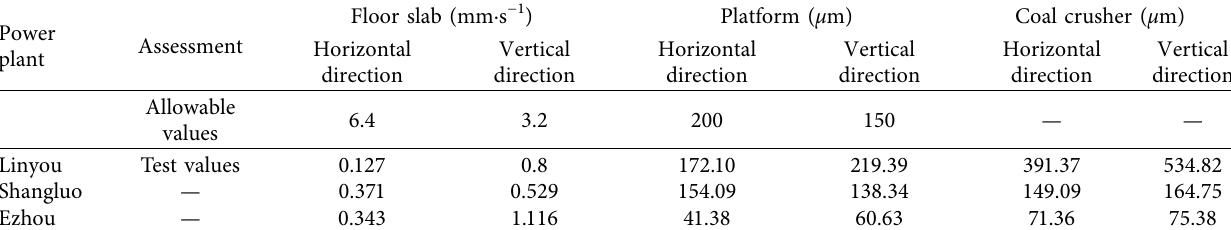
Table 4: Comparison of measured and allowable